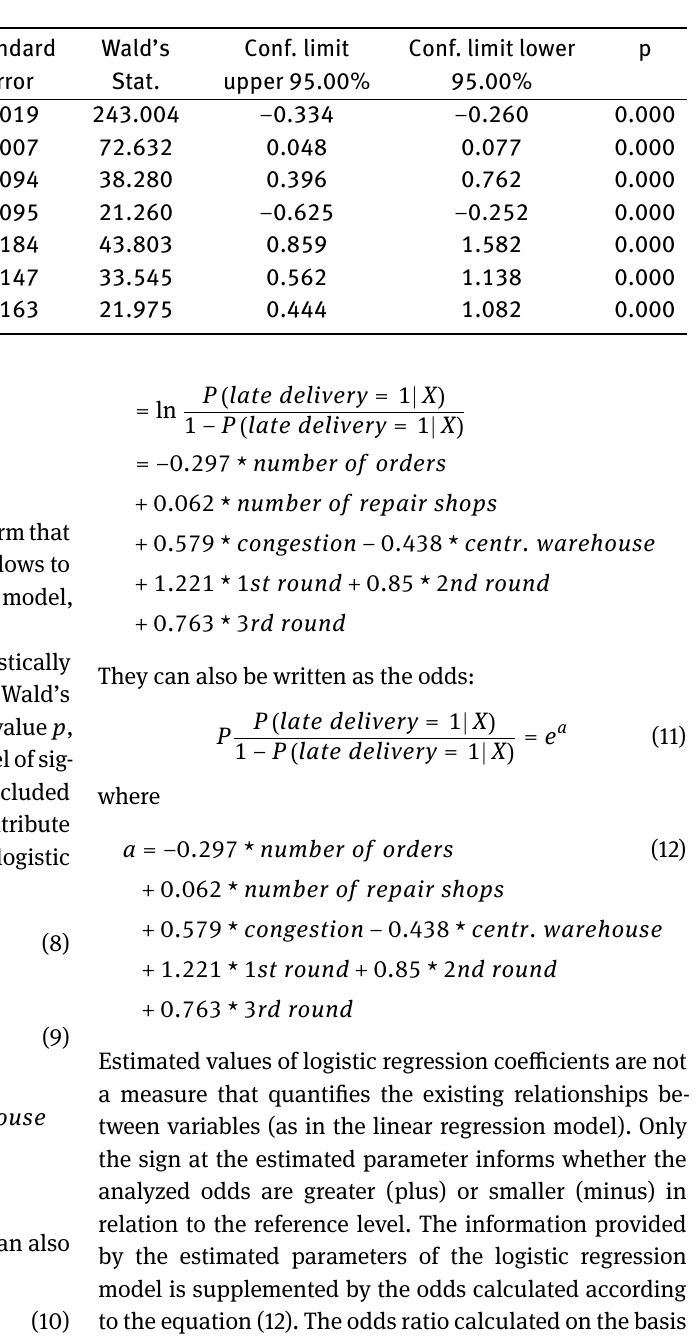
Figure 4: Some of interaction graphs of a dependent variable and predictors. Table 3: Parameters of the logistic regression model and their